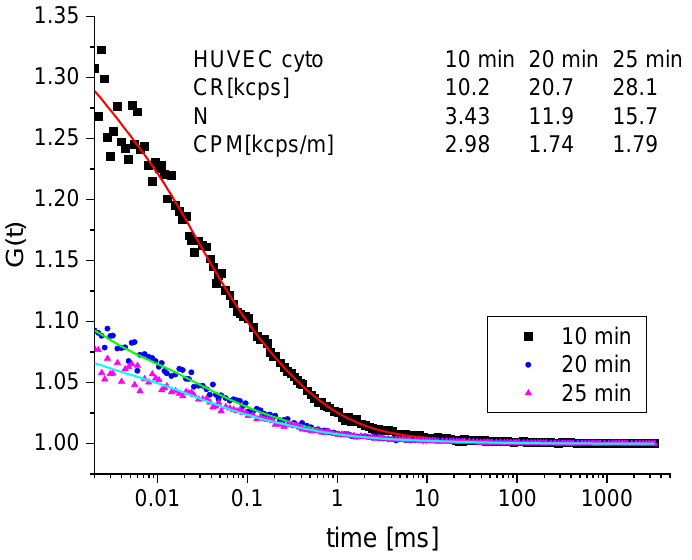
Figure 8. Correlation functions measured in the cytoplasm of an HUVEC cell at 10, 20, and 25 min, after adding the DAF-2DA dye (100 nM) to the cell-surrounding medium.